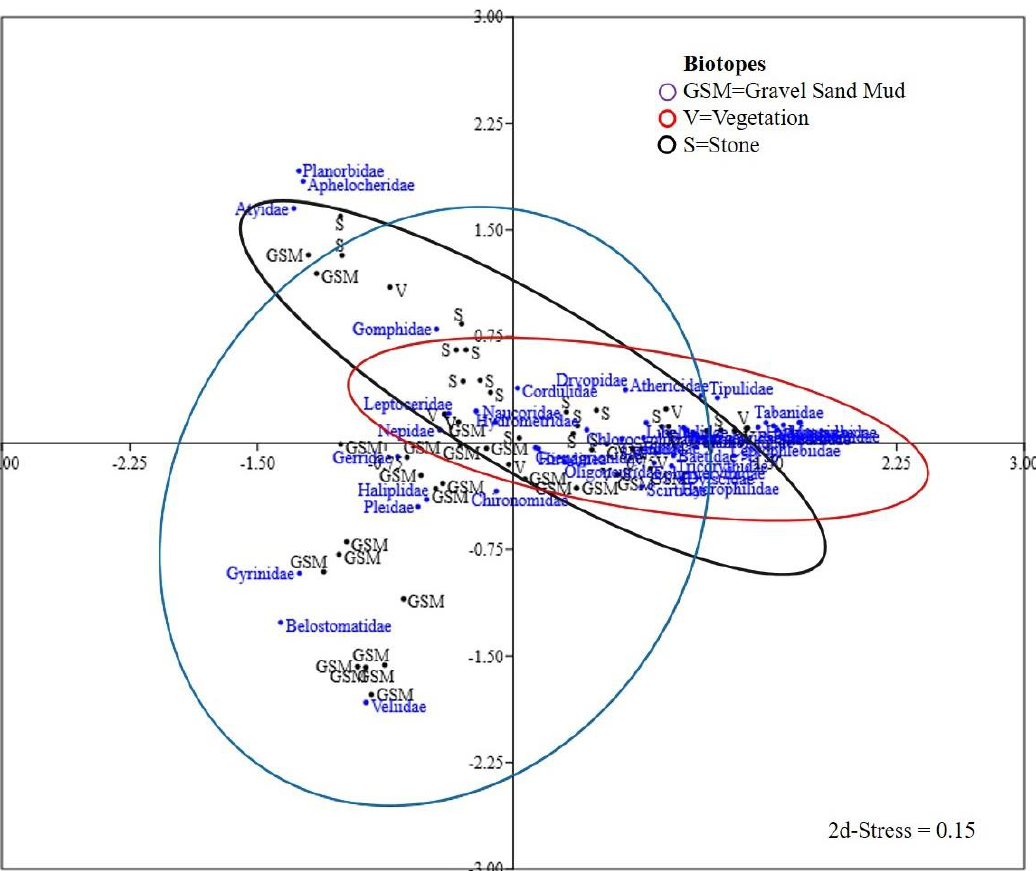
Figure 5. Cluster analysis multidimensional scaling (MDS) ordination of biotopes based on taxa recorded in biotopes in Kilombero Valley.